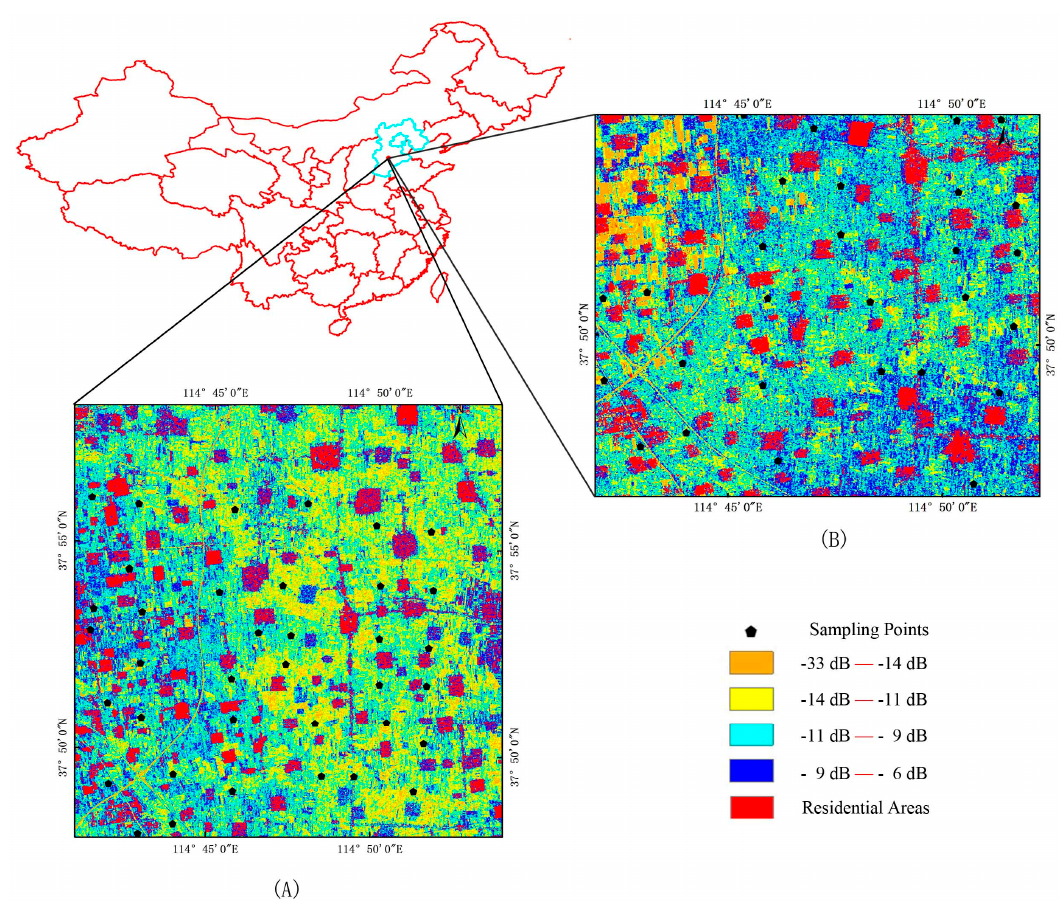
Figure 1. The geo-location of the Luancheng study area in China. The remote sensing images show the HH-polarized backscattering coefficients of GF-3 quad-polarization strip I (QPSI) data; ( A ) was acquired on 27 May 2017 with the crop type of wheat and ( B ) was acquired on 12 July 2017 with the crop type of corn. Red patches represent residential areas and black pentagons represent field measurement sampling points.